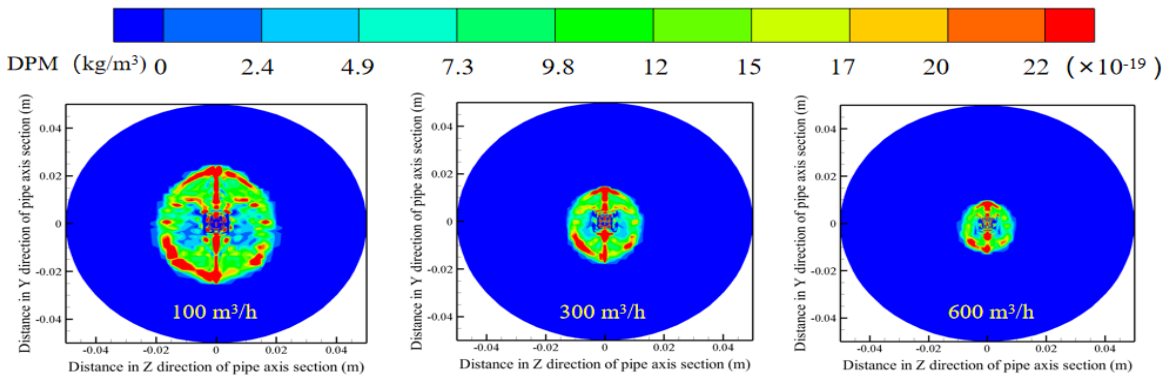
Figure 8. Particle mass concentration distribution at different flow